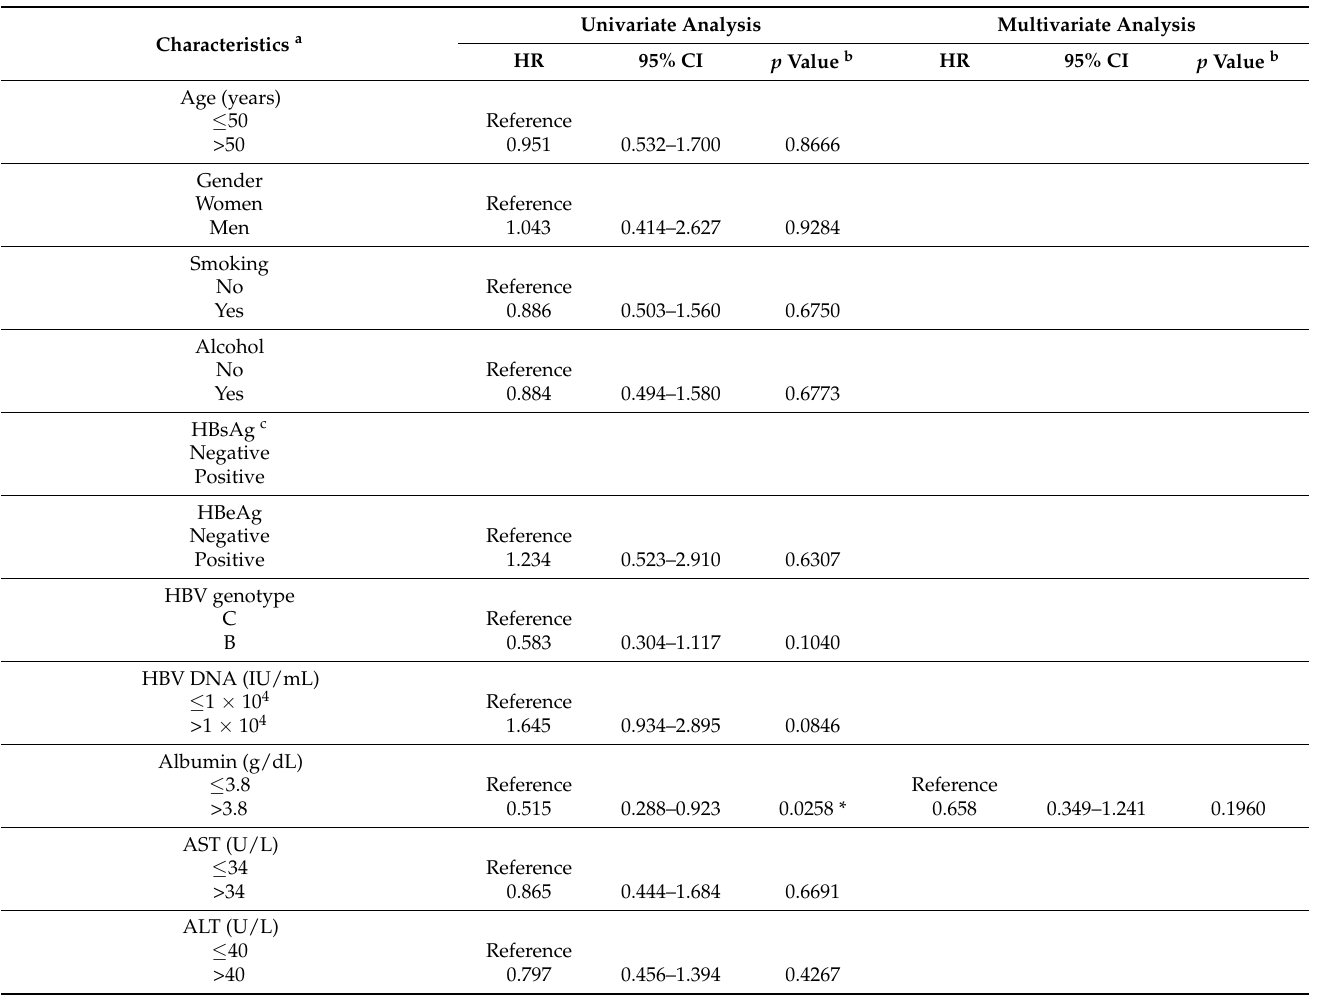
Table 3. Univariate and multivariate RFS analyses of clinicopathological characteristics in 75 HBV- related HCC